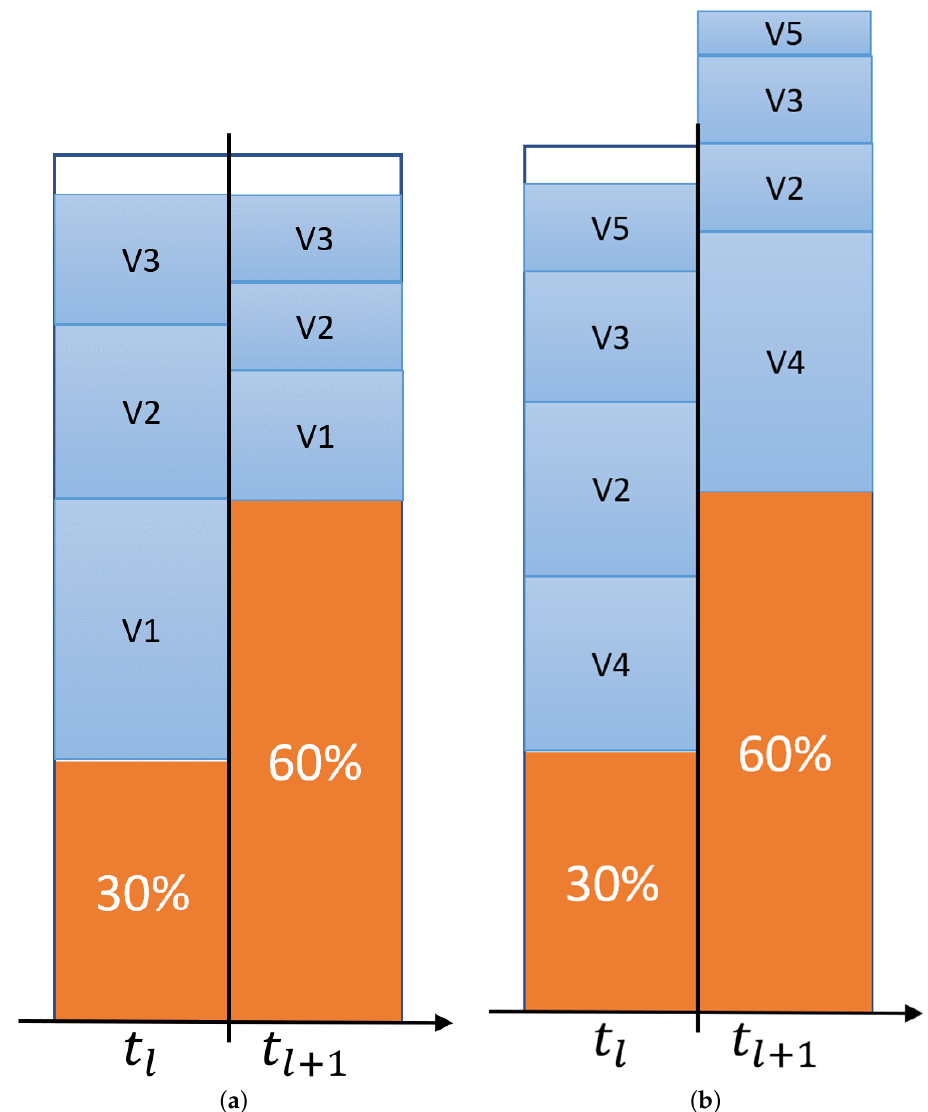
Figure 9. Example of VM placement on time competition: ( a ) VM placement 1; ( b ) VM placement